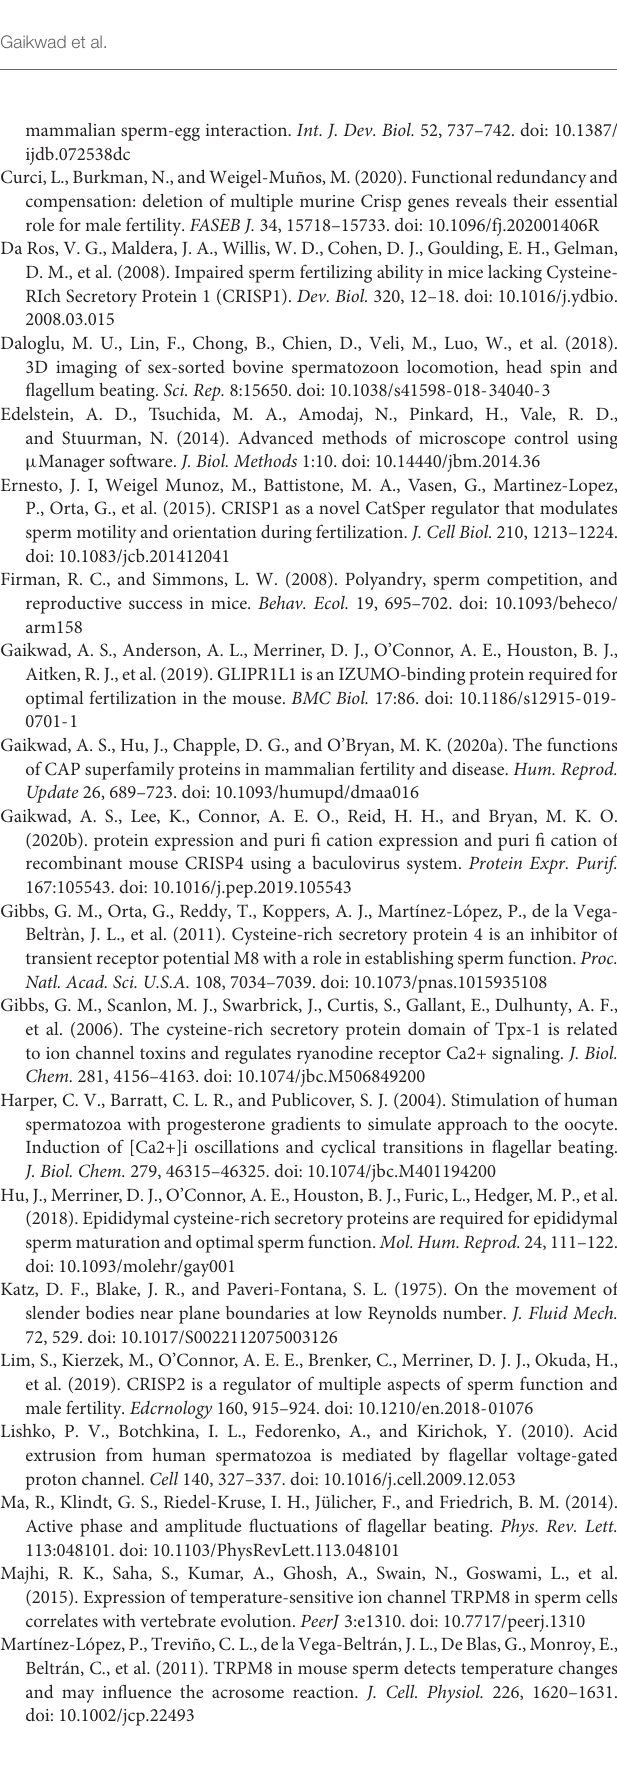
Frontiers in Cell and Developmental Biology |